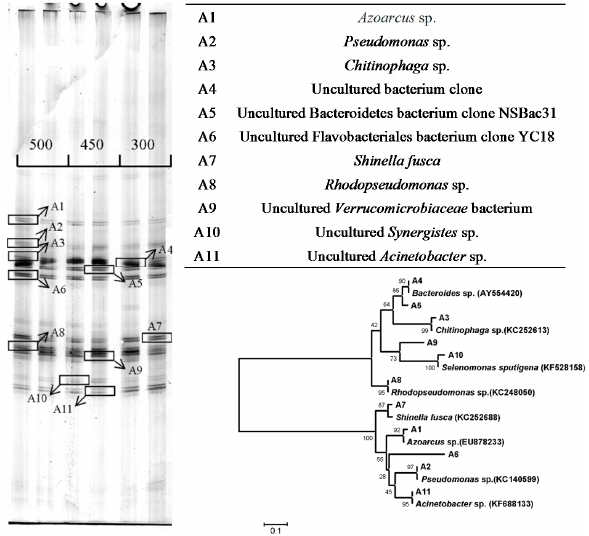
Figure 3. Characterization of cloned 16s rDNA gene fragments of different anodes and phylogenetic trees showing the relationships between the anode community and related species.